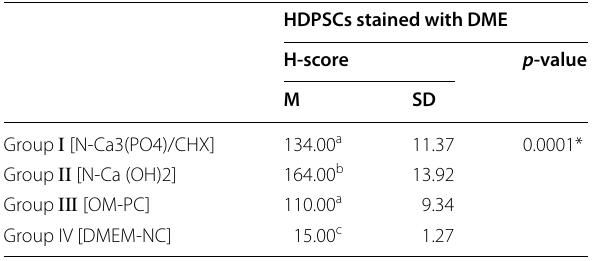
Table 4 Assessment of DMP-1 protein expression in HDPSCs using immunofluorescence staining